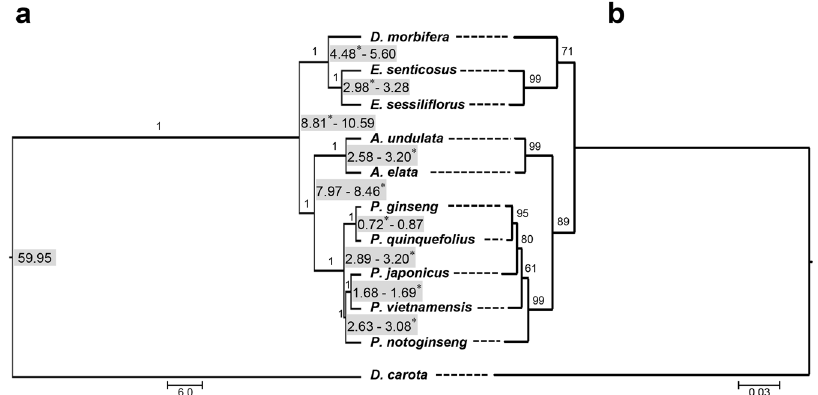
Figure 5. Phylogenetic tree and divergence time of 10 Araliaceae species. ( a , b ) Phylogenetic trees were generated based on cp protein-coding sequences ( a ) and nrDNA ITS sequences (ITS1-5.8S-ITS2) ( b ). Dashed lines connect the positions of each species in the two trees. Numbers next to nodes indicate average divergence time ( * ) based on Ks values (Table 2), and median divergence time using the BEAST program with 95% highest posterior density. The number above each branch refers to the Bayesian posterior probability ( a ) and ML bootstrap values ( b